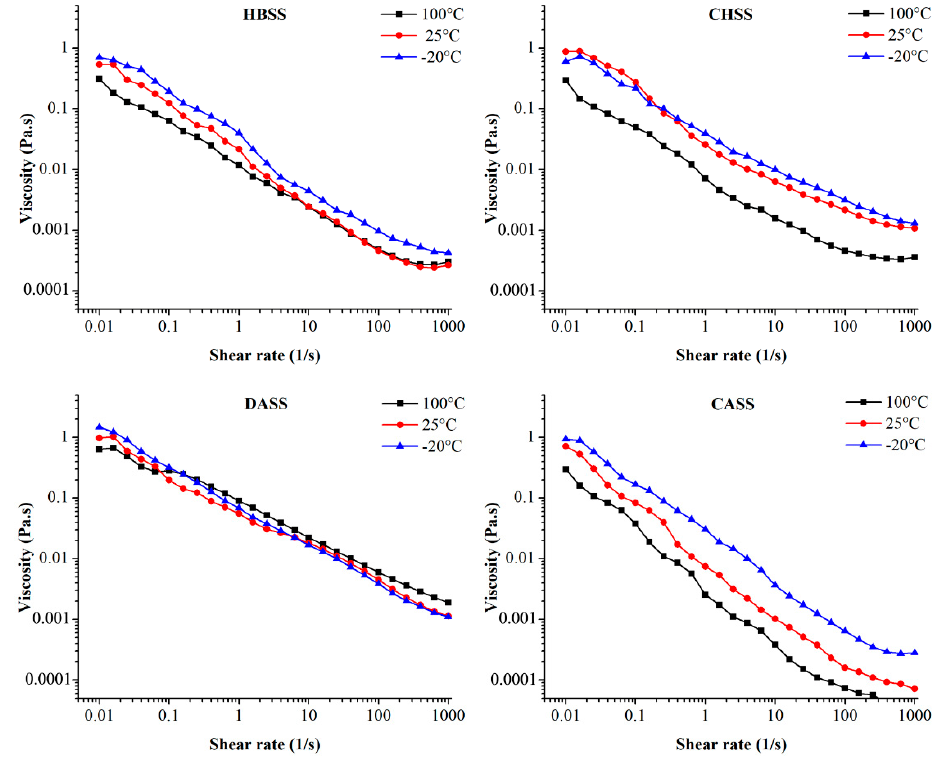
ff erent temperature